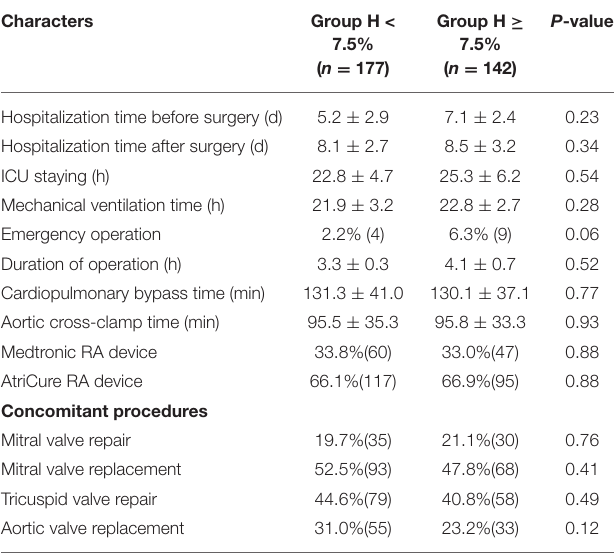
TABLE 3 | Perioperative variables comparison.